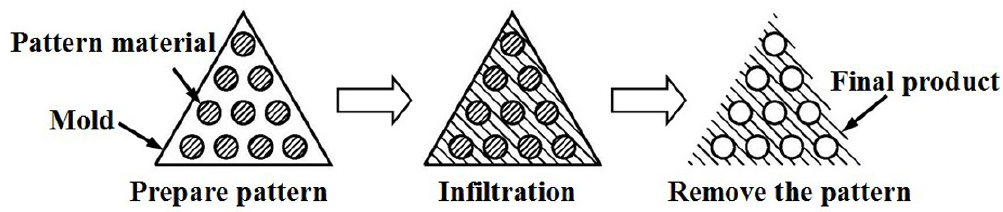
Figure 34. Schematic representation of the three-step replication process ([232], modified).